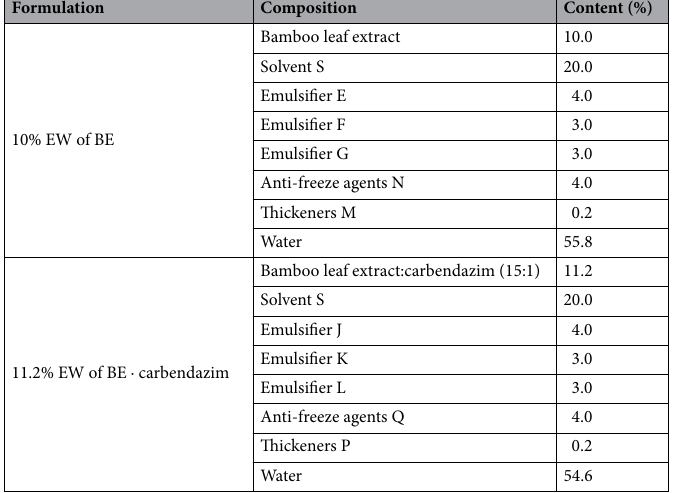
Table 3. Formulation of the 10% EW of BE and 11.2% EW of BE ·